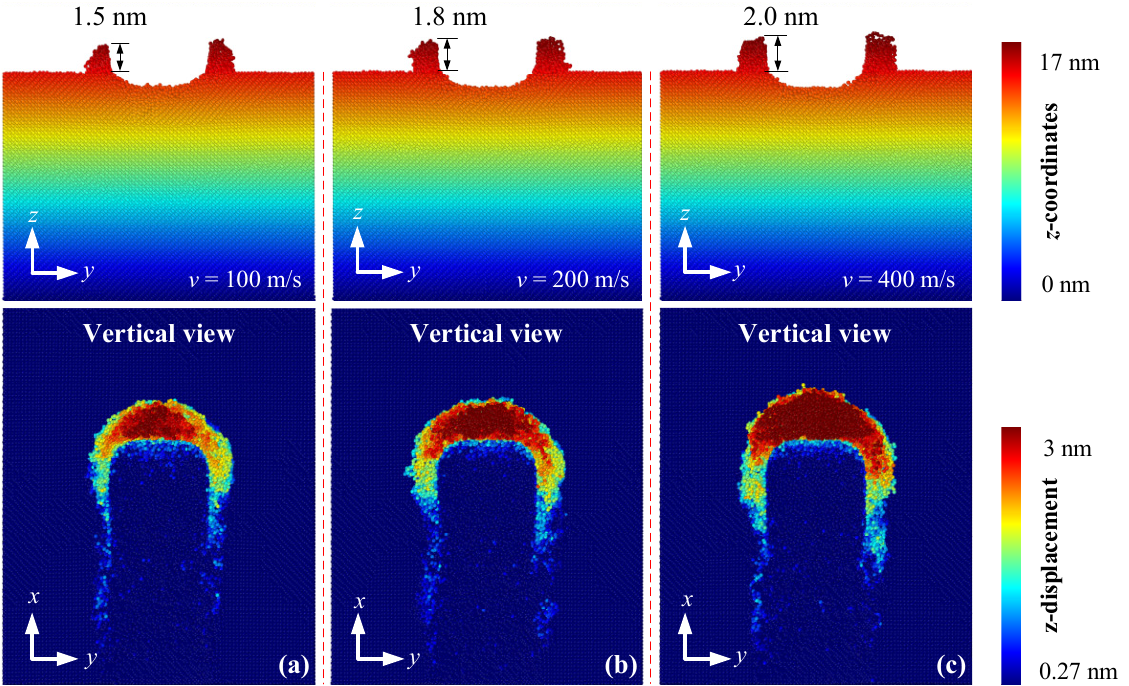
Figure 4. The lateral bulge and surface morphology of machined SiC at cutting speed of ( a ) 100, ( b ) 200, and ( c ) 400